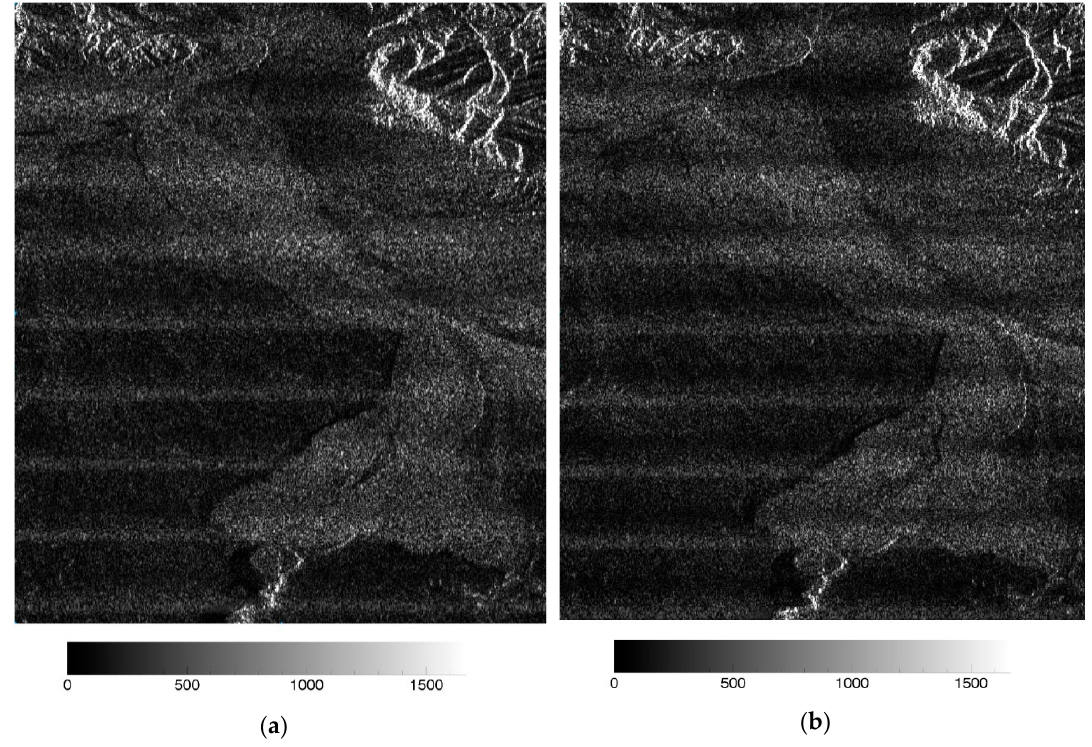
Figure 4. Gaofen-3 SAR images. ( a ) The master image; ( b ) the slave image. Filtering the two images with different burst central time differences |∆𝑇| , we found different coherence values after interferometry. This coherence was estimated from the interferometric images. |∆𝑇| versus coherence is shown in Figure 5.